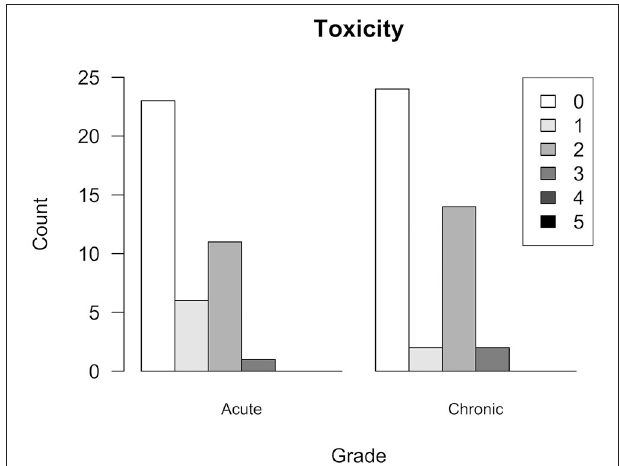
Events (CTCAE v4.0) during and ≤ 90 days after respective course of SRS; chronic toxicity occurring > 90 days after respective course of SRS. Graph shows highest grade of toxicity observed for individual patients during any course of